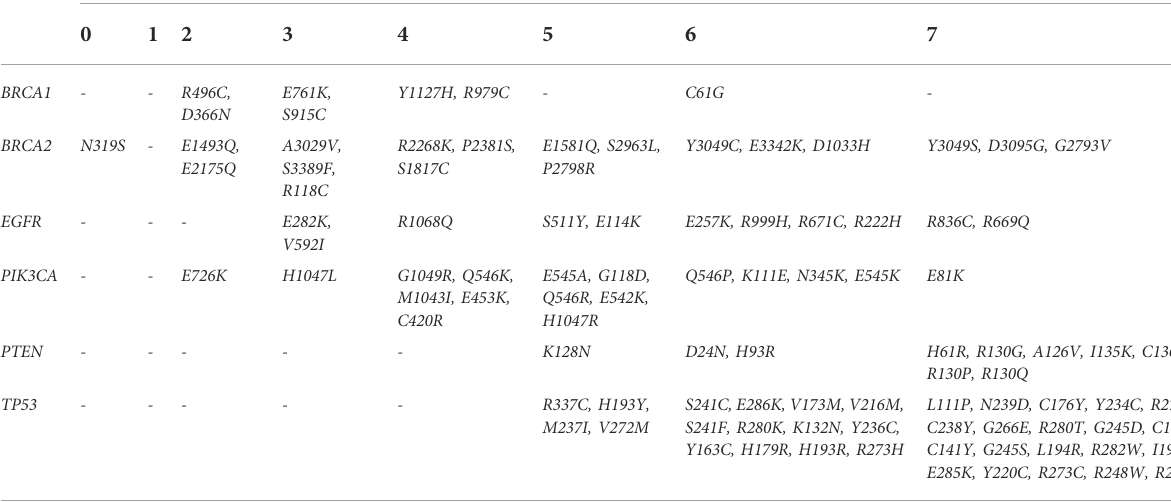
TABLE 3 SNPs that were scored by the framework and reported in ≥ 90th percentile of breast cancer samples. Genes Scores received by the SNPs in our prediction